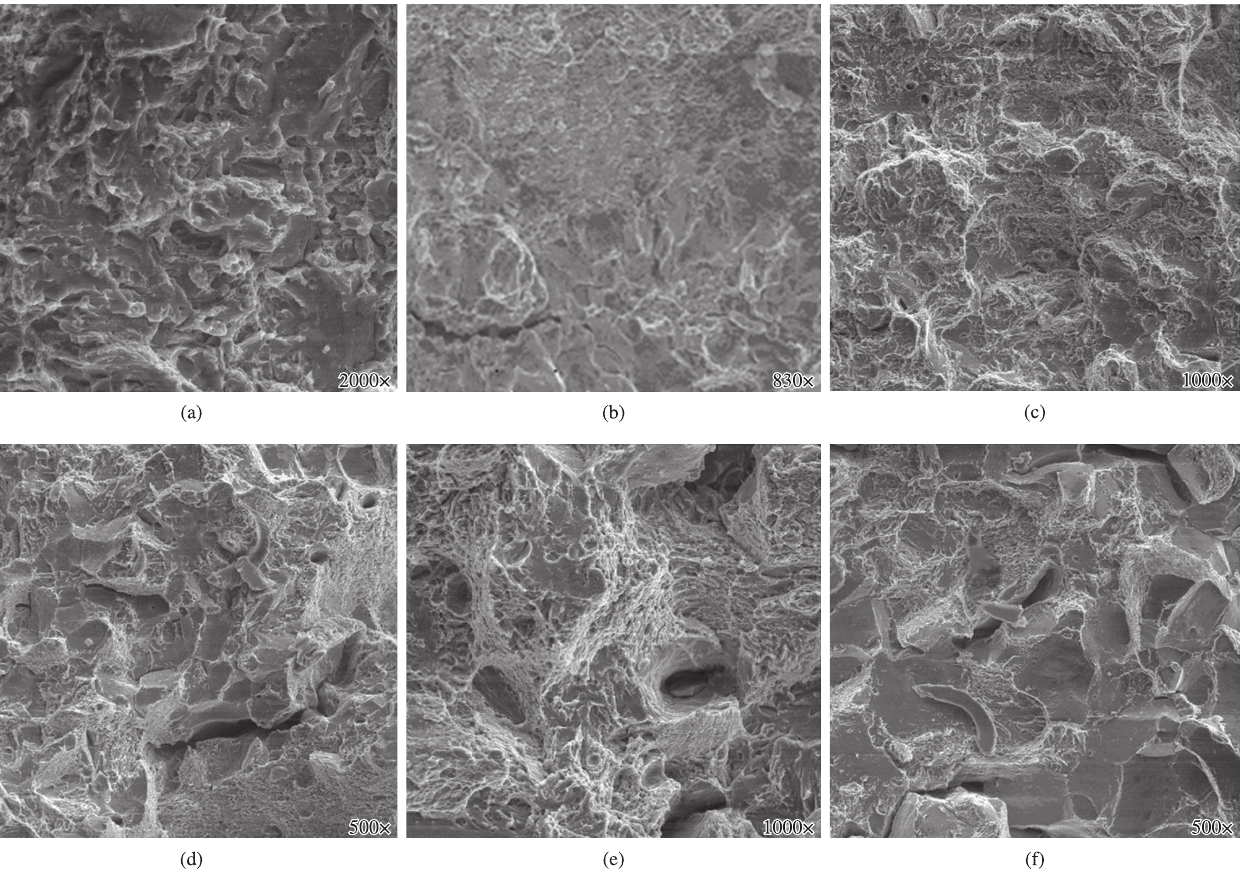
Figure 11. Fracture surface (central part of the fracture) of the impact specimens. Steel with 0.012 wt. (%) P (steel A) austenitized at: a) 850 °C; c) 900 °C; and e) 1000 °C. Steel with 0.025 wt. (%) P (steel C) austenitized at: b) 850 °C; d) 900 °C; and f) 1000 °C. The specimens were tempered at 500 °C for 64